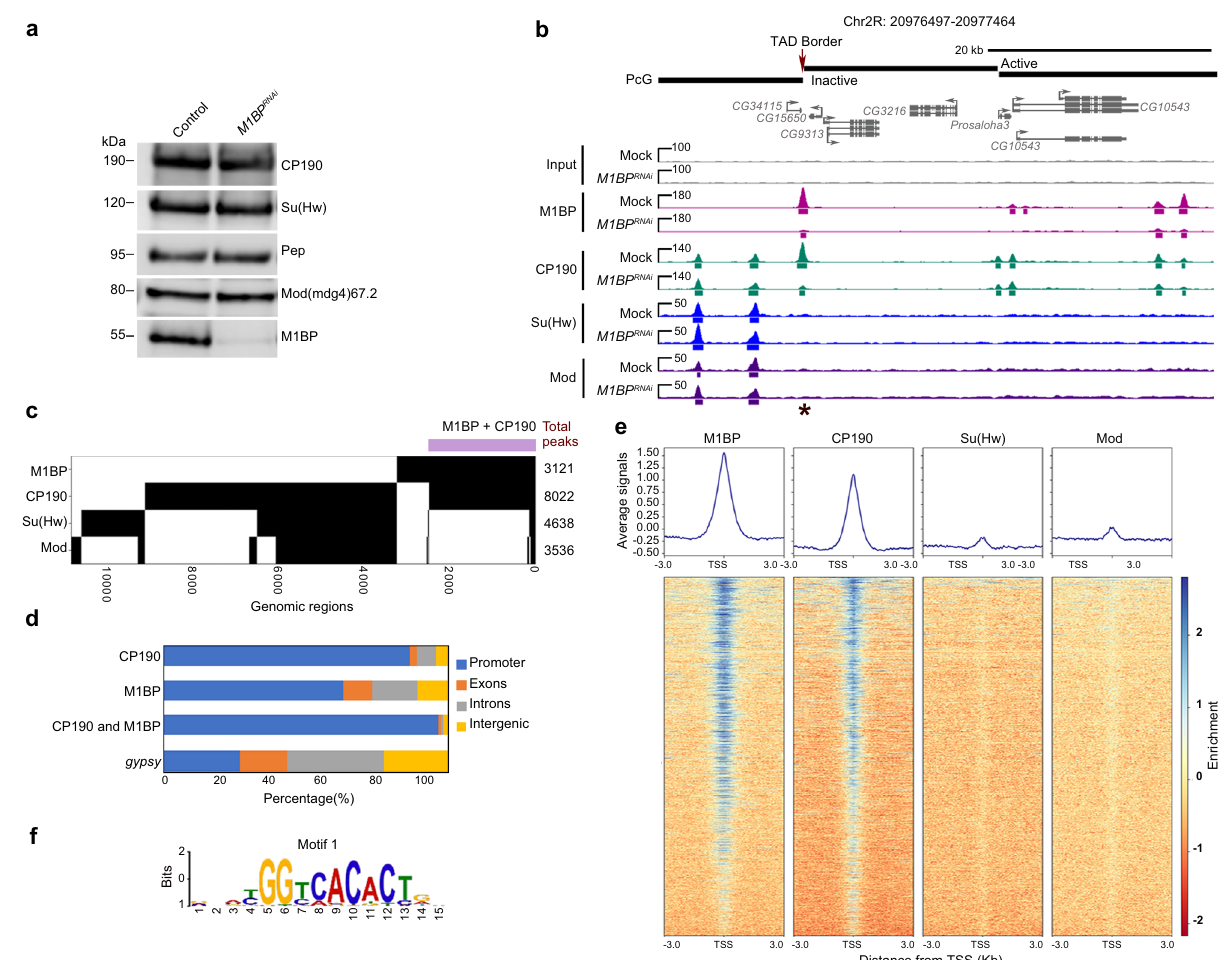
Fig. 3 M1BP extensively colocalizes speci fi cally with CP190 throughout the genome. a Western blotting of total lysates from Kc control and M1BP knockdown cells showing knockdown ef fi ciency of M1BP and no effects on protein levels of insulator proteins, with Pep as loading control. Samples from the same experiment were run on different lanes of the same gel for proteins with similar molecular weights. Western blotting was performed for three independent biological replicates with similar results. b Screenshot example of ChIP-seq pro fi les showing in Kc cells M1BP co-localizing with CP190 but not Su(Hw) or Mod(mdg4)67.2. Asterisk indicates a particular peak of interest measured in Fig. 6c, site 7. c Binary heatmap of M1BP, CP190, Mod(mdg4)67.2, and Su(Hw) binding sites in control cells ordered by supervised hierarchical clustering. Each row represents a single independent genomic location, and a black mark in a column represents the presence of a particular factor: 2461 (79%, purple bar) peaks of 3121 total M1BP peaks overlap with CP190, 163 (5.2%) M1BP peaks overlap with Su(Hw) peaks, and 217 (7%) M1BP peaks overlap with Mod(mdg4)67.2. d Bar plot shows distribution of M1BP, CP190, and gypsy (Su(Hw)/Mod(mdg4)67.2/CP190 all present) binding sites with respect to genomic features. e Heatmaps of M1BP, CP190, Su(Hw), and Mod (mdg4)67.2 peaks in control cells sorted independently by decreasing average ChIP-seq signals normalized to inputs. Reads are centered on 6307